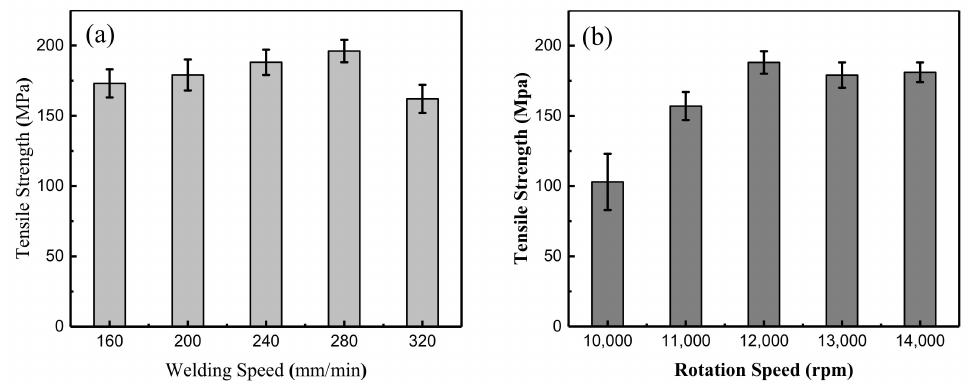
Figure 6. Tensile strength of T2 / H62 joint under di ff erent process parameters: ( a ) di ff erent welding speeds; ( b ) di ff erent rotation